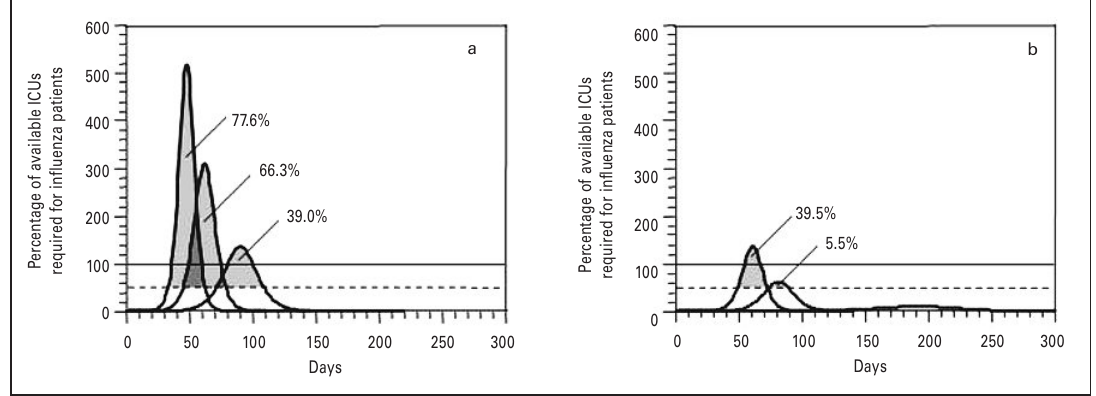
Figure 4 Demand of intensive care, representing (from left to right) 90%, 50% and 10% percentiles, respectively, of 100000 random outcomes, ordered by the size of the peak of hospital bed occupancy.The curves show the percentage of the currently avail- able ICU beds in Switzerland (6.4 per 100000 inhabitants), assuming that 15% of hospitalized patients need intensive care. Horizontal lines indicate 50% and 100% level of the available ICU capacity.The gray areas under the curves indicate what percentage of cases with ICU demand cannot receive proper treatment if at most 50% of ICU beds can be made available for influenza patients. (a) Social distancing alone. (b) Social distancing combined with